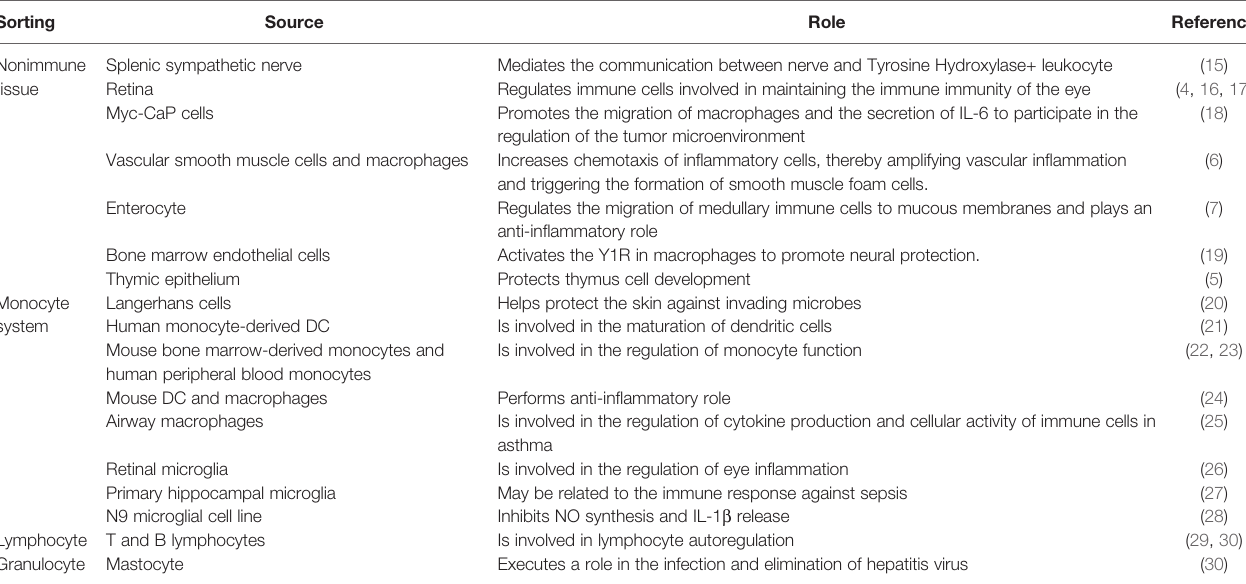
TABLE 1 | Source and role of neuropeptide